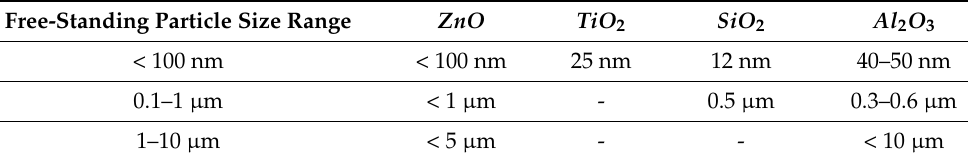
Table 1. Free-standing size of ZnO , TiO 2 , SiO 2 , and Al 2 O 3 particles embedded in single or mixed formulation in